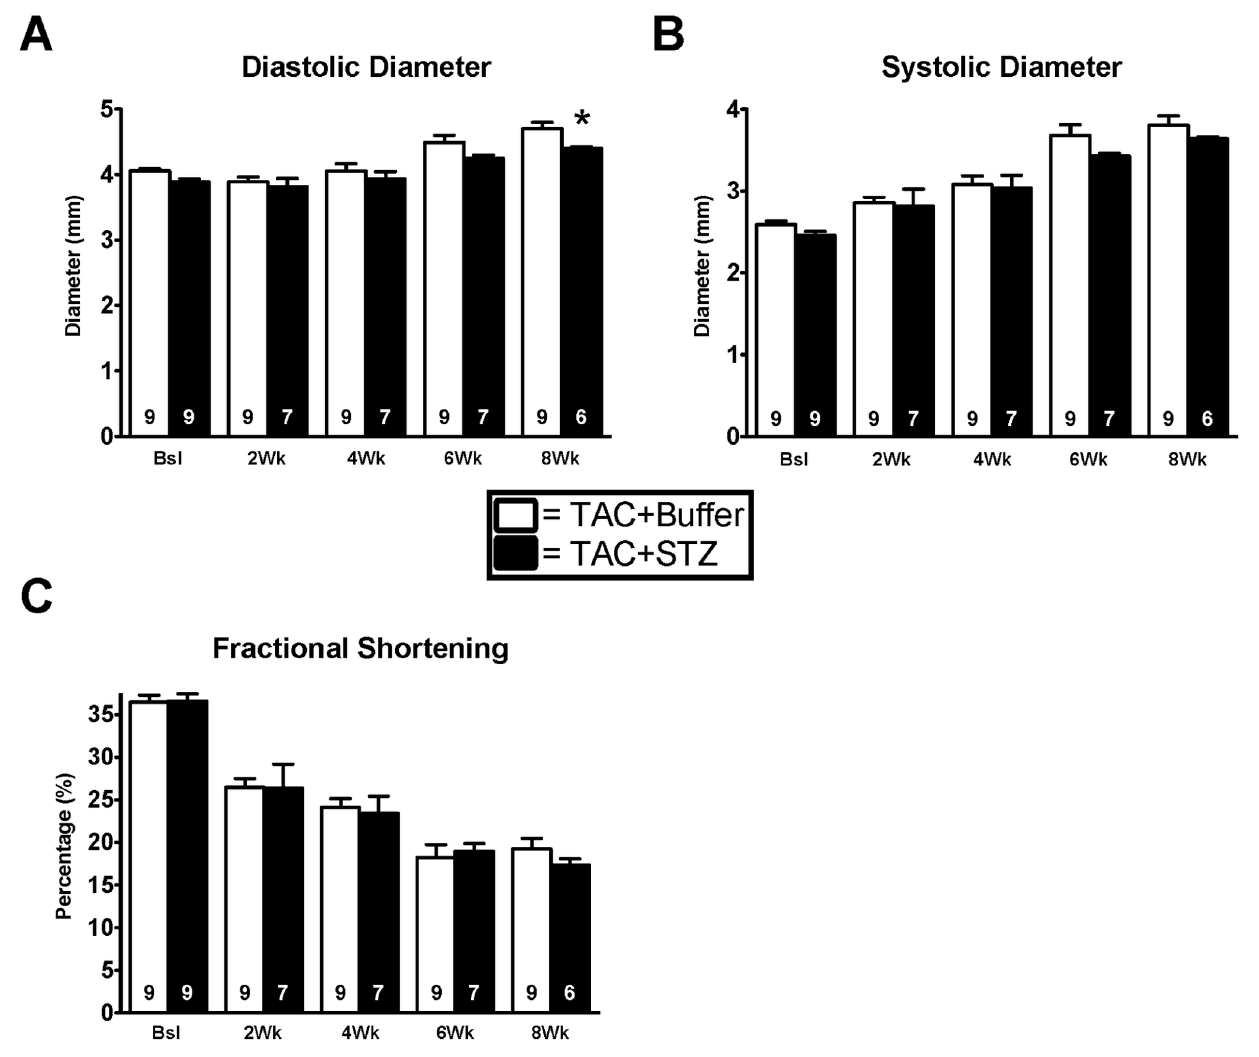
Figure 7. Pressure overload is not exacerbated by hypoinsulinemia via streptozotocin treatment. ( A ) Fractional shortening remained unchanged between the groups through eight weeks of TAC. ( B - C ) Diastolic and systolic diameters were assessed via long axis m-mode echocardiography on the Acuson Sequoia C512 imaging system. No change between TAC+Buffer and TAC+STZ treated mice was observed through eight weeks of TAC. Results are expressed as means ± S.E., *, p< 0.05.